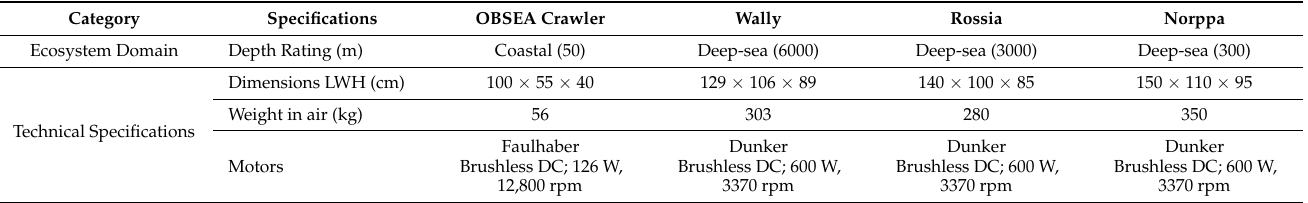
Comparing different features of the OBSEA crawler, with the Wally, Rossia, and Norppa